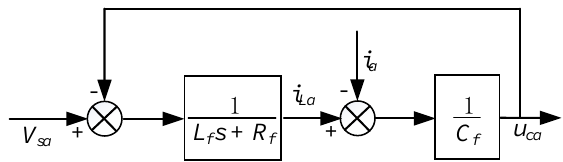
Figure 3. Control object structure diagram of H-bridge